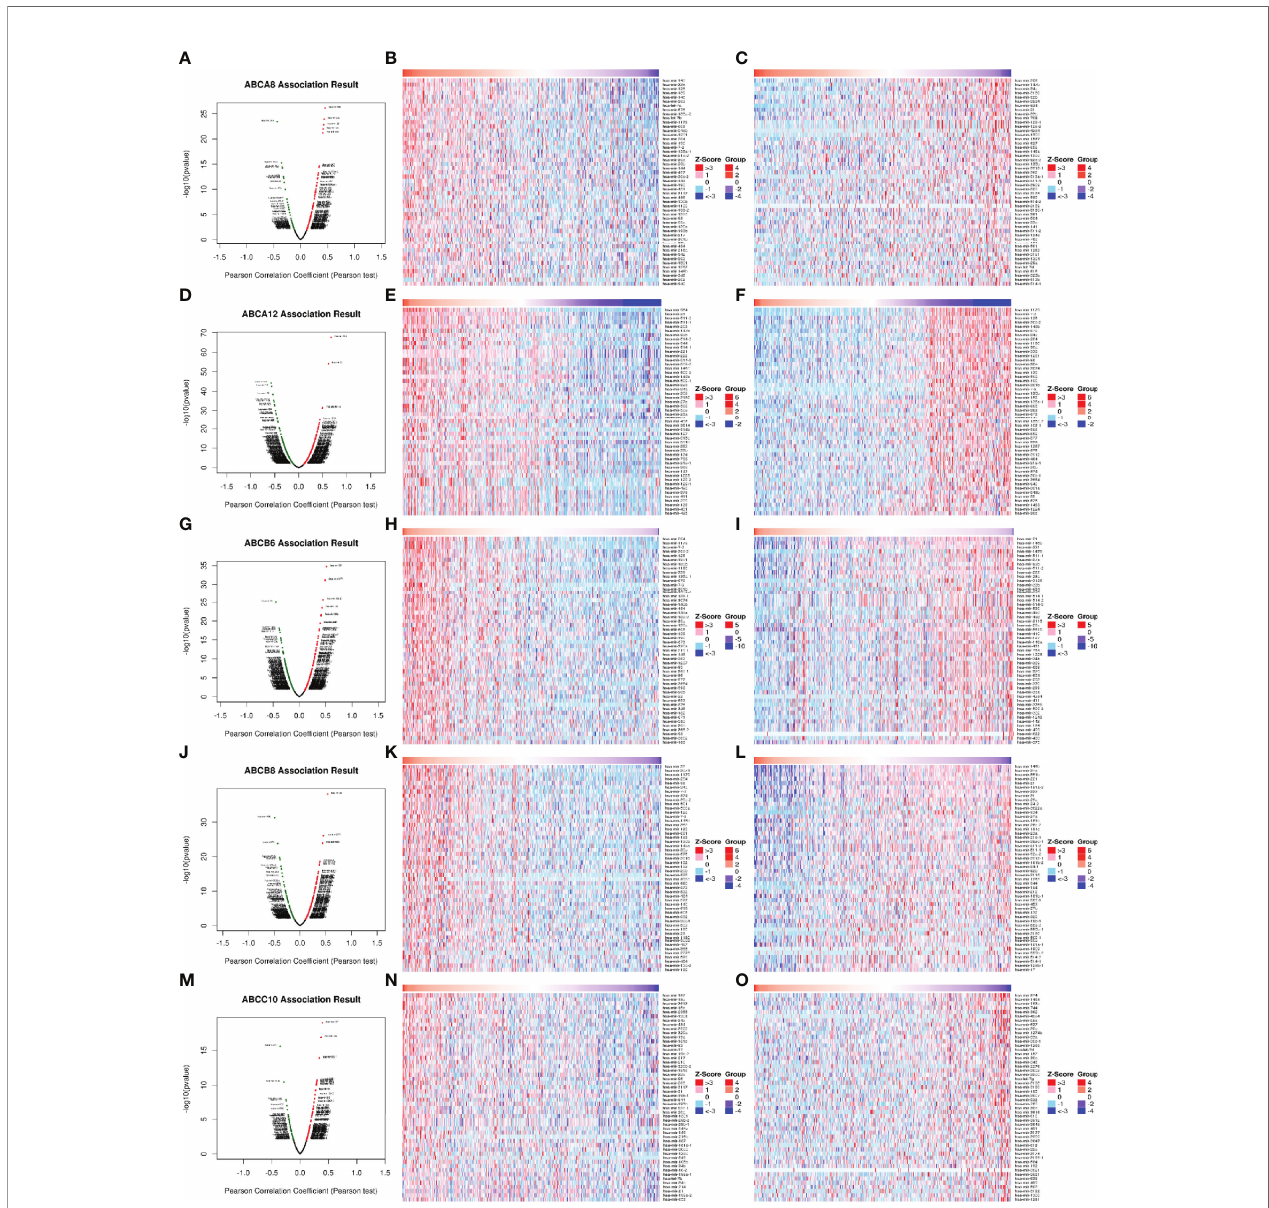
FIGURE 5 | Correlation of differentially expressed miRNAs with fi ve hallmark ABC transporters in TC. (A, D, G, J, M) Differentially expressed miRNAs, which were correlated with fi ve hallmark ABC transporters, were analyzed by Pearson test, and visualized in form of volcano plots. (B, E, H, K, N) The top 50 miRNAs, which were positively correlated with fi ve hallmark ABC transporters, were visualized in form of heatmaps. (C, F, I, L, O) The top 50 miRNAs, which were negatively correlated with fi ve hallmark ABC transporters, were also visualized in form of